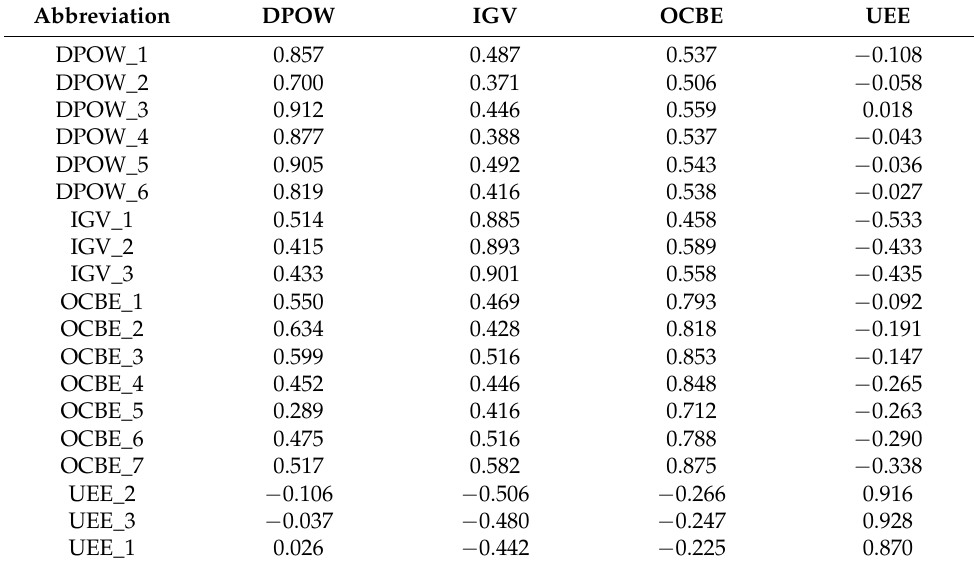
Table 2. Cross loading results.